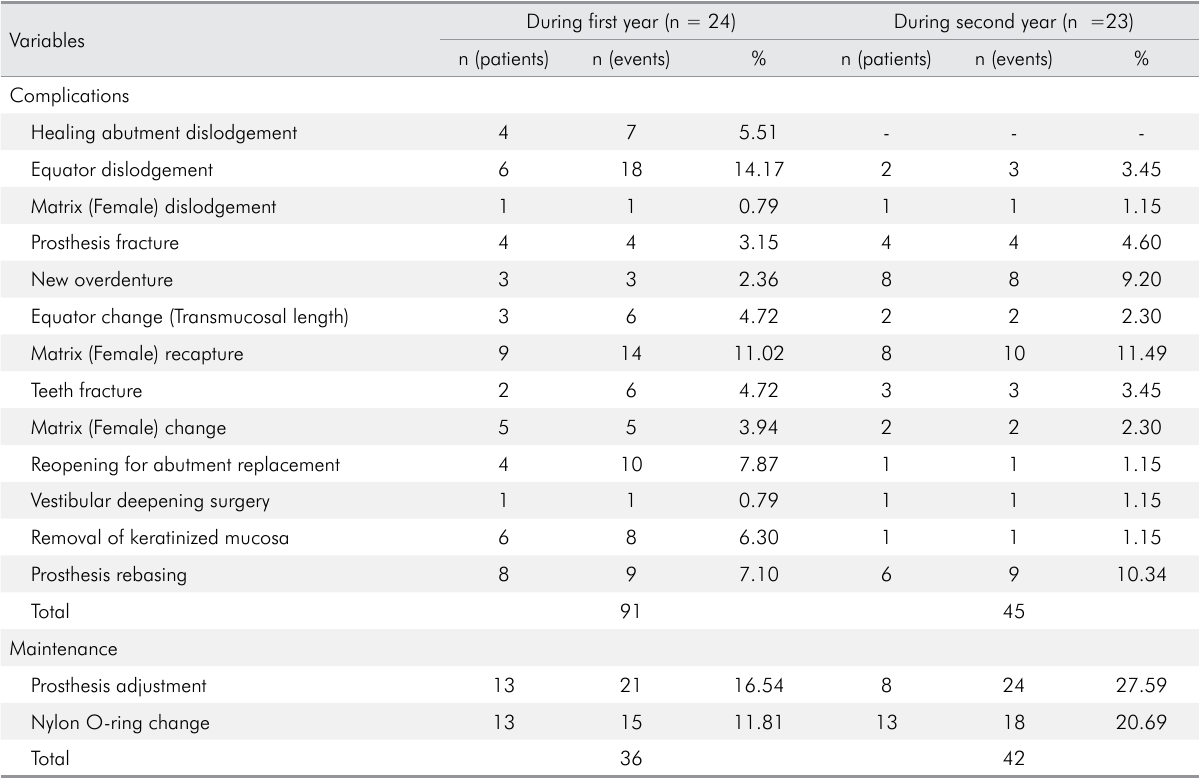
Table 2. Type, number of patients, number of events and relative percentage of events during the first and second years of occlusal